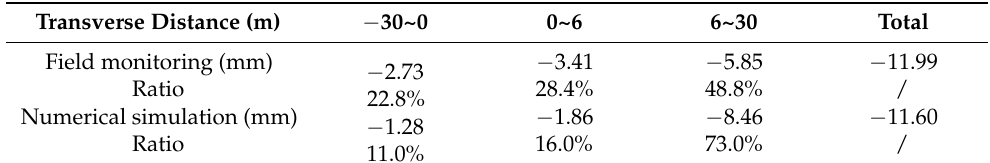
Table 6. The stratum settlement value at 3 m above the tunnel at different stages of shield tunneling in hole 2 #.